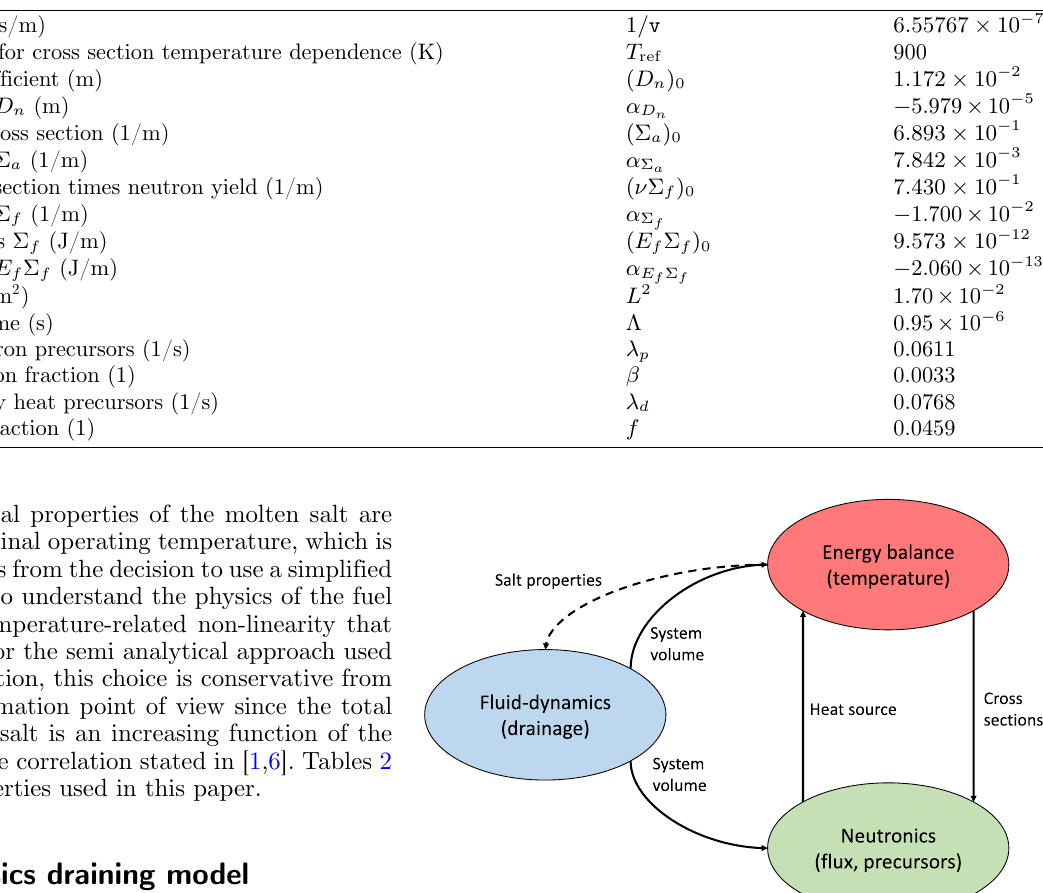
Table 3. Neutronic parameters.